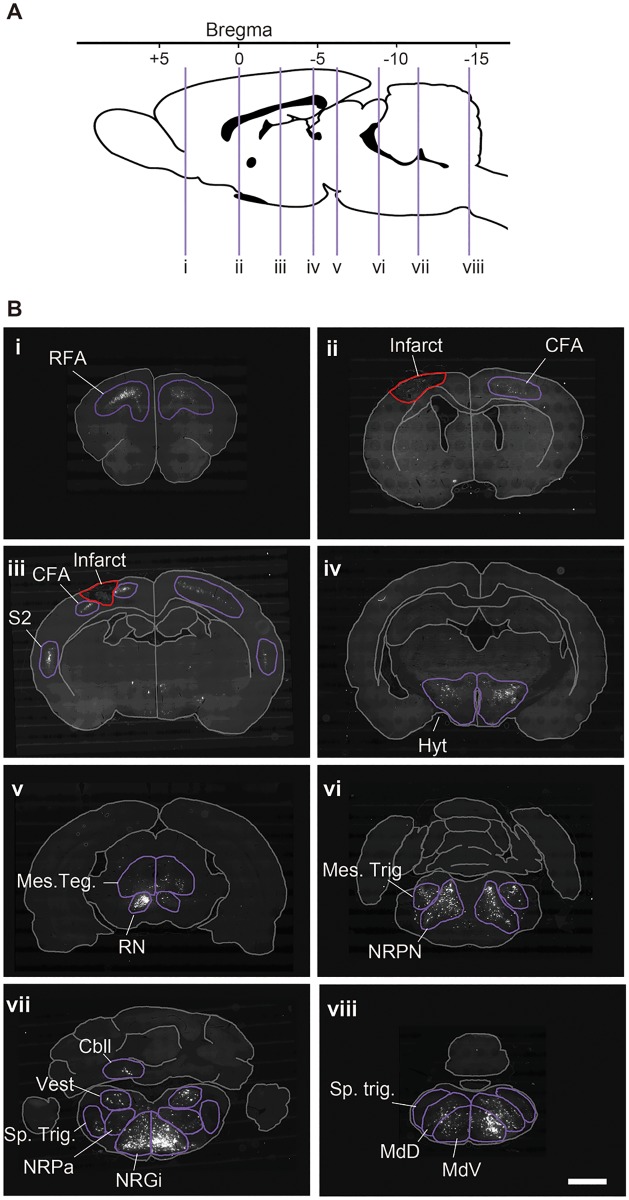
Distribution of Fast blue-positive neurons.(A) The sagittal brain atlas indicating the level of the section in B (purple line; i-viii). (B) Representative pictures of the brain sections in the cerebral cortex (i, ii and iii), thalamus and hypothalamus (iv), midbrain (v), pons (vi) and medulla oblongata (vii and viii). The neurons projecting to the contralesional spinal cord at C7-8 were labeled with Fast blue. Infarct is indicated with a red line and the observed area of Fast blue-positive cells are indicated with a purple line. The names of the brain areas are abbreviated as follows: Rostral forelimb area (RFA), caudal forelimb area (CFA), secondary sensory area (S2), hypothalamic area (Hyt), mesencephalic tegmental area (Mes. Teg.), red nucleus (RN), nucleus reticularis pontis (NRPN) mesencephalic trigeminal nuclei (Mes. Trig.), deep cerebellar nuclei (Cbll), nucleus reticularis gigantocellularis (NRGi), nucleus reticularis parvocellularis (NRPa), spinal trigeminal nuclei (Sp. Trig.), vestibular nuclei (Vest), dorsal medullary reticular nucleus (MdD), and ventral medullary reticular nucleus (MdV). Scale bar = 1 mm.